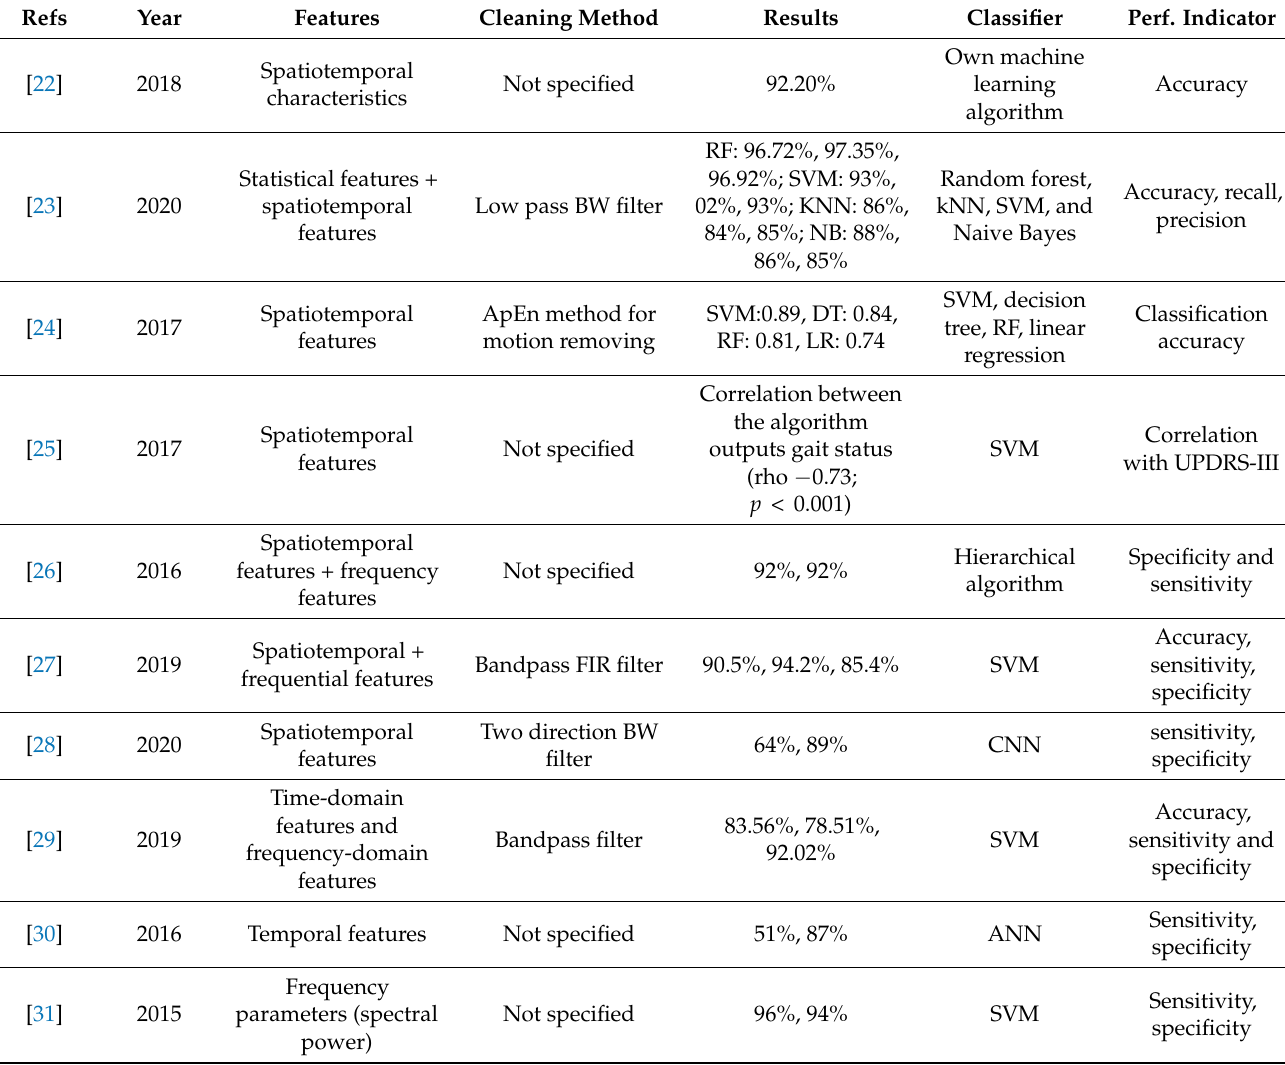
Table 3. Summary of the results, type of features introduced to the model, year of publication, and main results obtained. Acronyms: BW—band width; SVM—support vector machines; kNN—k-nearest neighbors; NB—Naive Bayes; DT—decision tree; RF—random forest; LR—linear regression; UDPRS—unified Parkinson’s disease rating scale; CNN—convolutional neural networks; ANN—artificial neural network; FIR—finite impulse